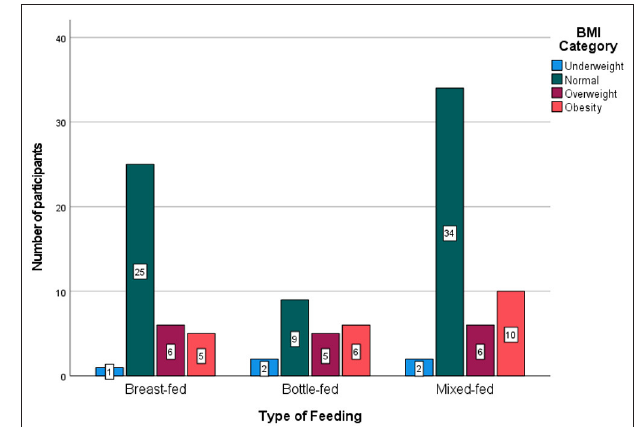
FIGURE 4 | Body mass index (BMI) categories among the three feeding groups. The BMI measures were normal, more often in the breastfed group (68%) than in other groups (e.g., 41% in the bottle-fed group), and more obese BMI levels were seen in the bottle-fed group than in other groups ( P =